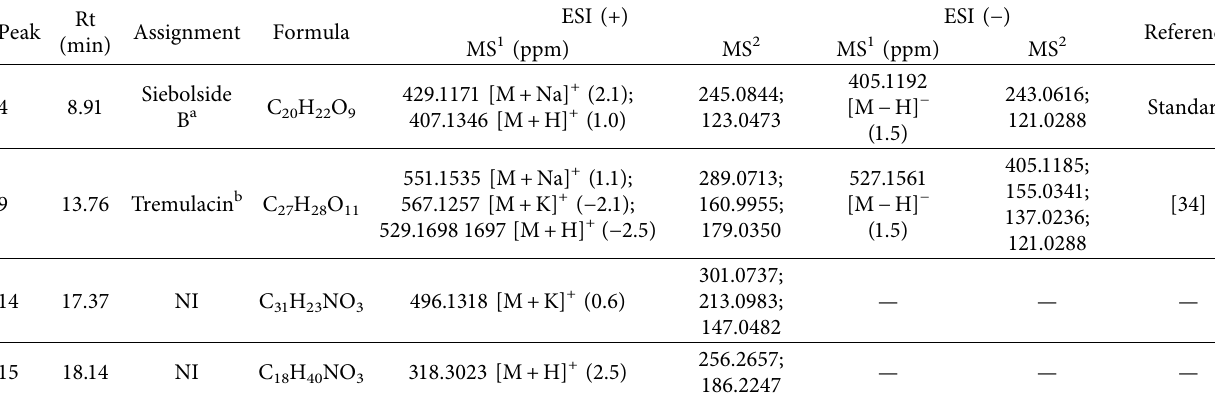
Figure 5: HCA heatmap analyses of 4 peak content in MFB and FFB of P. tomentosa . The X axis refers to P. tomentosa samples. The Y axis refers to the screened compounds. The red and blue colors in the plot refer to higher and lower compound content than the mean value, respectively. Table 2: Four screen compounds identified by